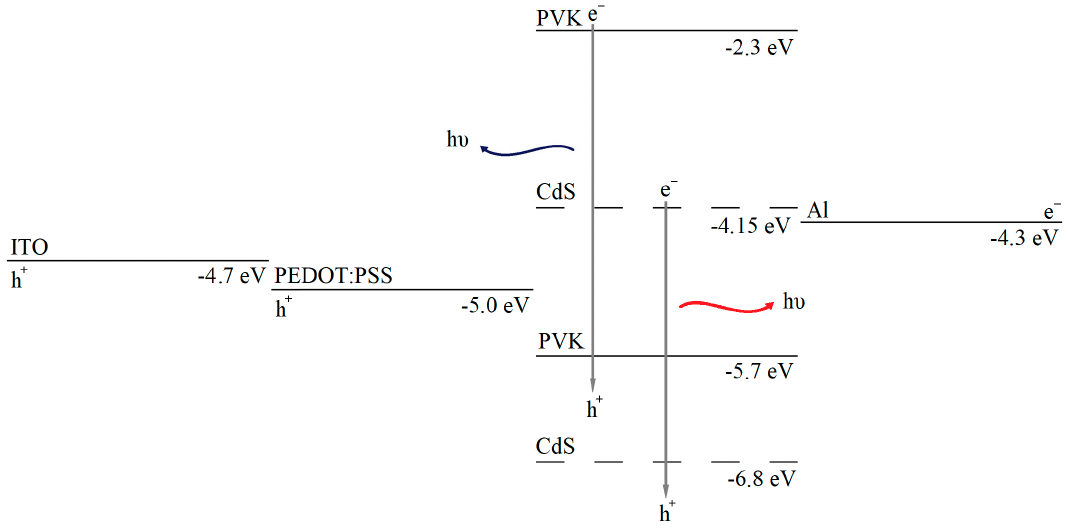
Figure 12. Threshold voltage (V) and Current density (mA / cm 2 ) measured at threshold voltage for the LEDs from Figure 11A.